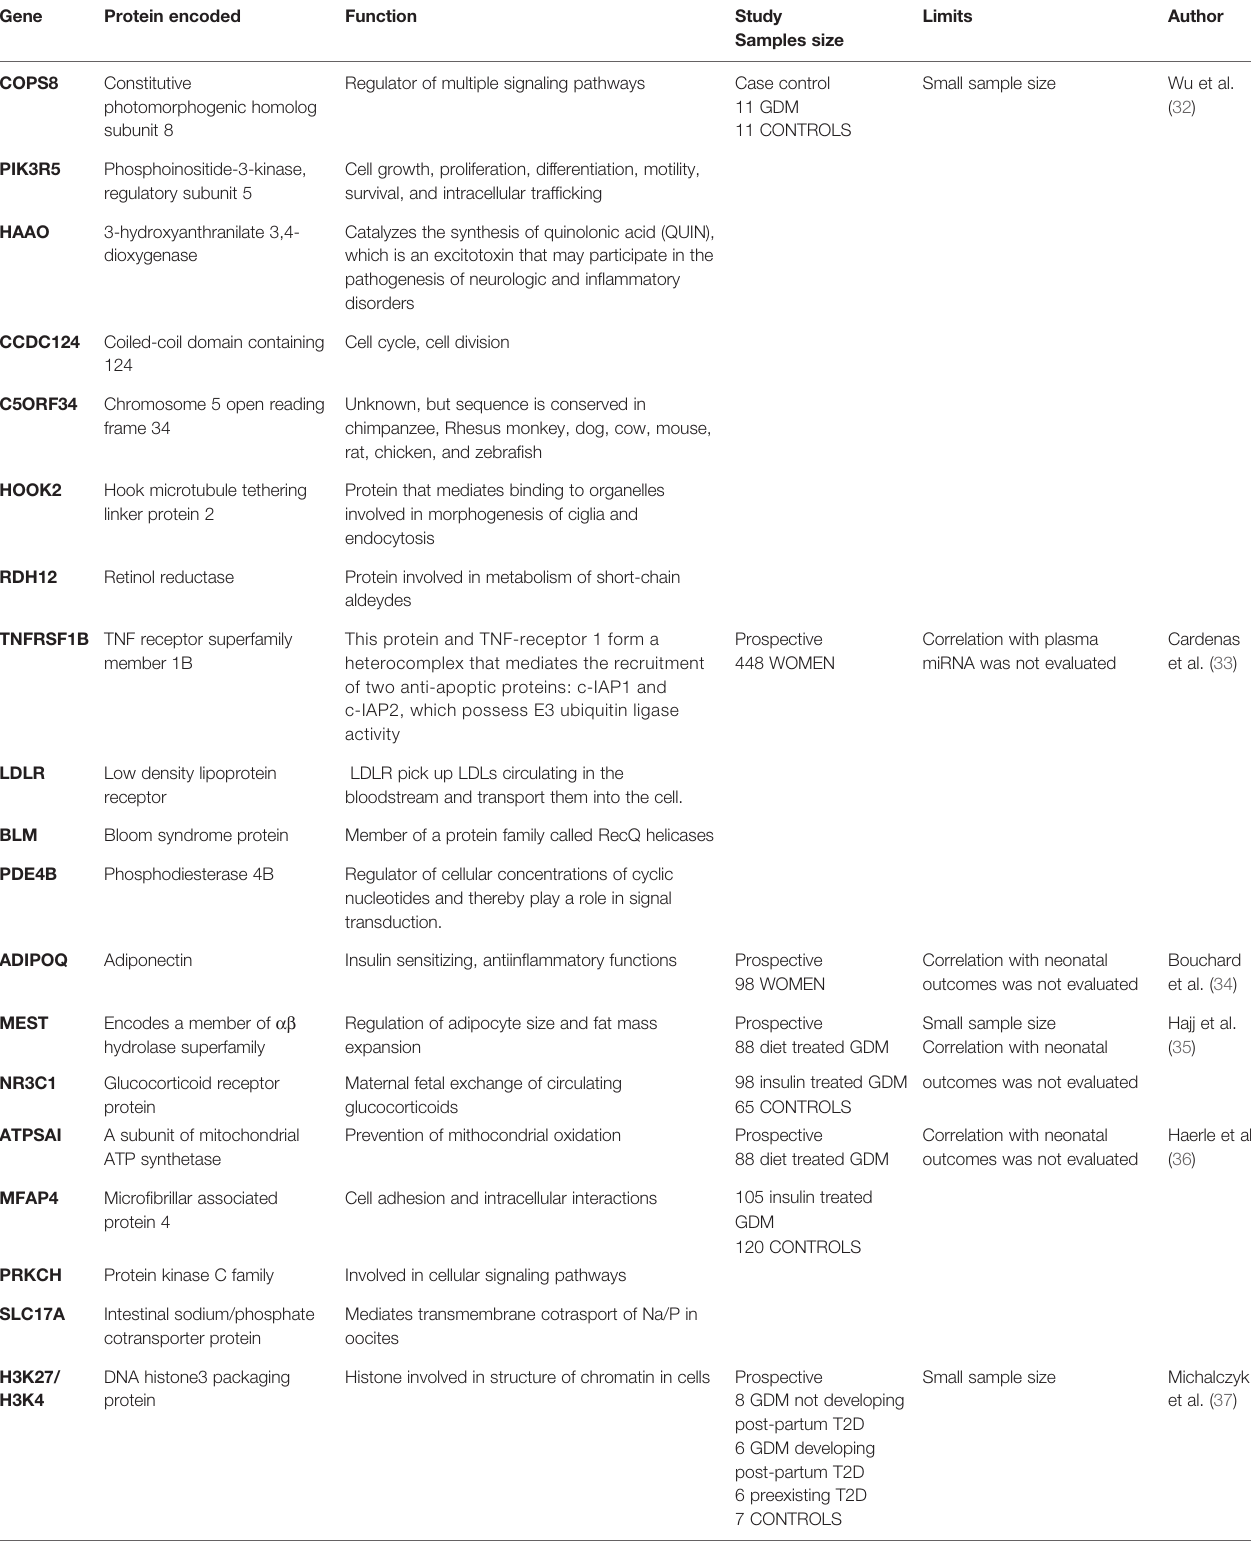
TABLE 3 | Gene methylation in Gestational Diabetes